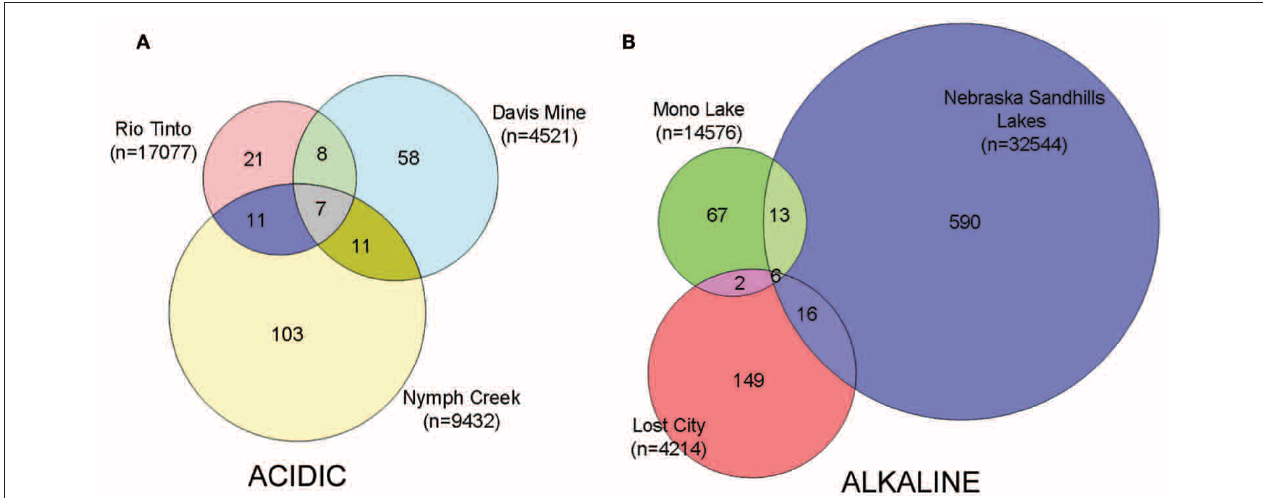
FIGURE 4 | Venn diagrams indicating the degree of overlap between (A) acidic OTUs and (B) alkaline OTUs. Total number of amplicon reads per sample is indicated in parentheses under the sample names.